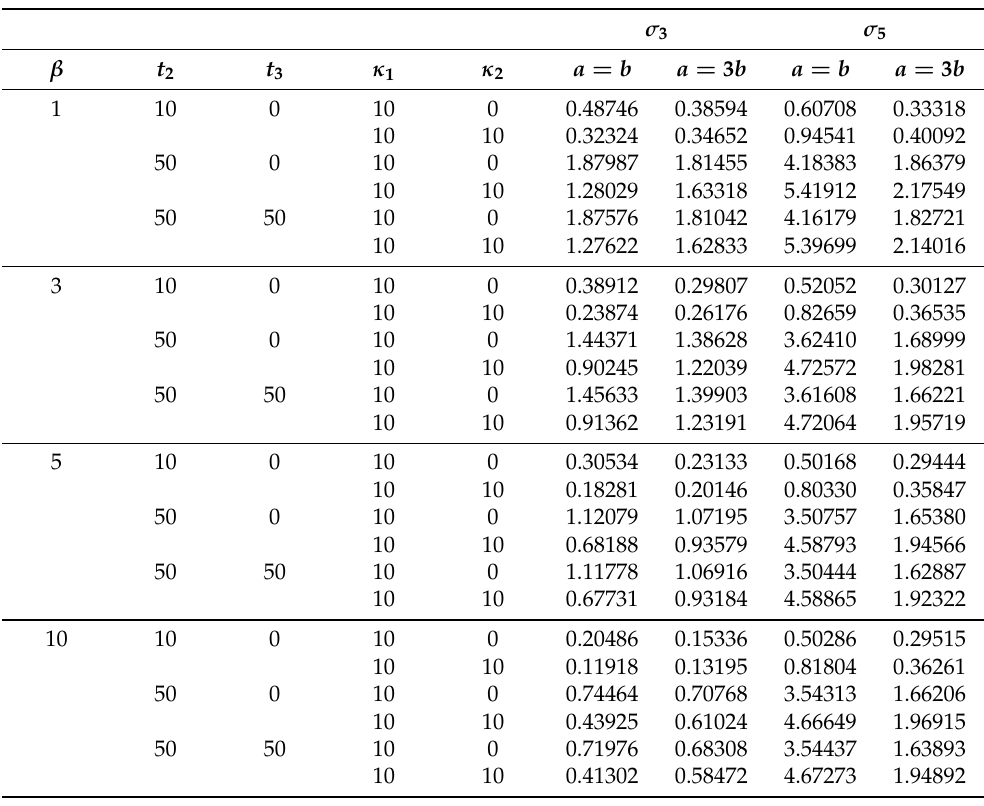
Table 7. Effects of the FG parameter β and thermal loads on the transverse normal stress σ 3 and transverse shear stress σ 5 of a sinusoidal distributed loaded FG plate resting on elastic foundations ( a = 10 h ).